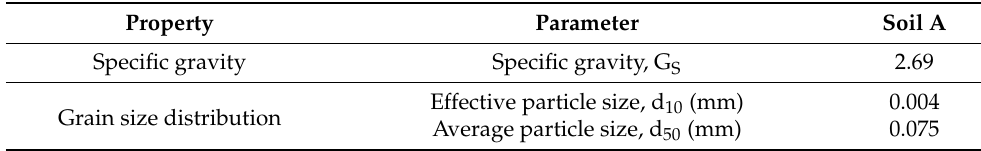
Table 1. Properties of the soil used in this